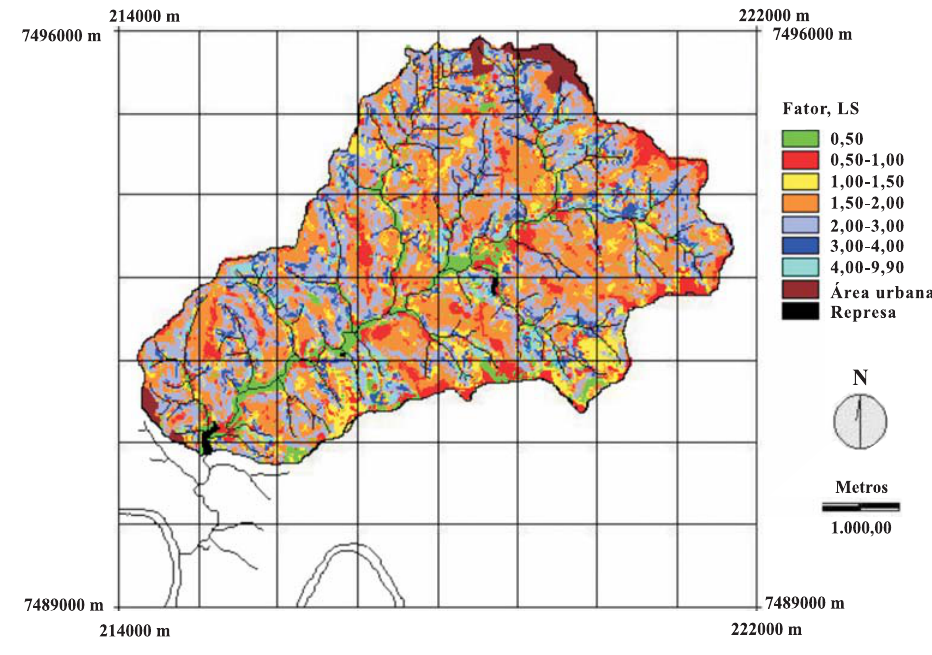
Figura 6. Mapa do fator LS para a área de estudo.